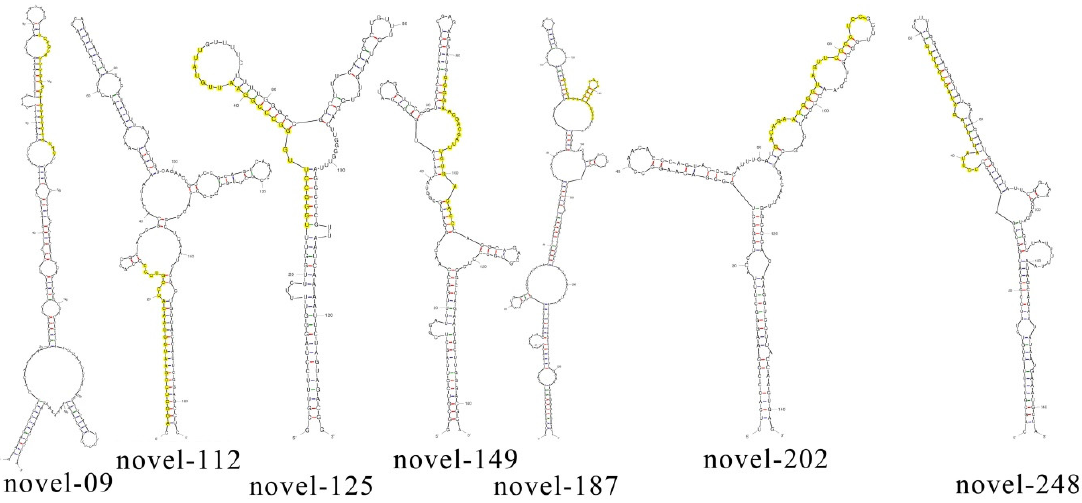
Figure 2. The predicted secondary structures of novel MicroRNAs (miRNA) precursors for seven novel miRNAs. Yellow color indicates mature miRNA.